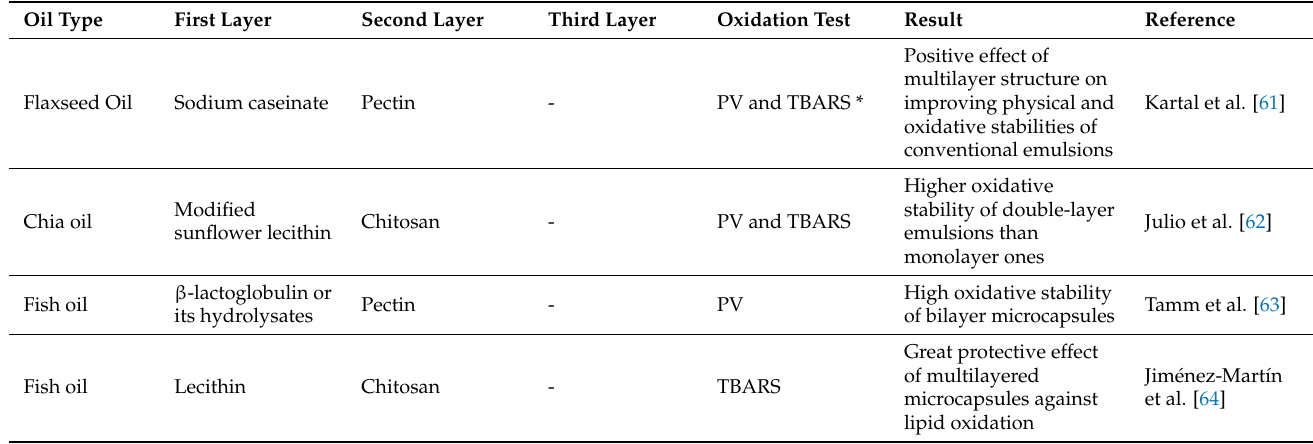
Table 2. Multilayer emulsions inhibited lipid oxidation at the interfacial